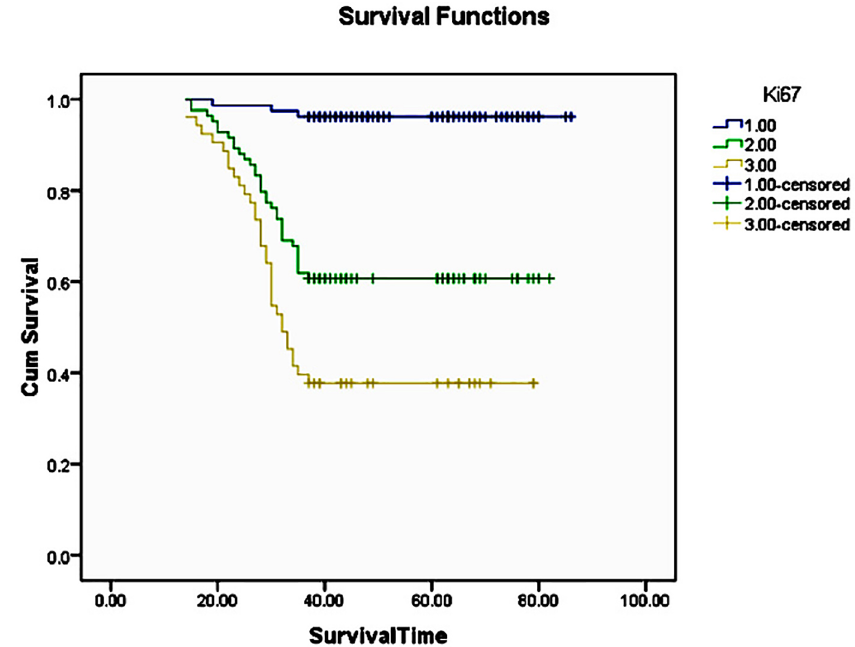
Figure 3- The Kaplan-Meier curve for 3 years disease free survival rate for oral squamous cell carcinoma with respect to 1: Low Ki67 labeling index (≤45), 2: Moderate Ki67 labeling index (46 to 60) and 3: High Ki67 labeling index (≥61)